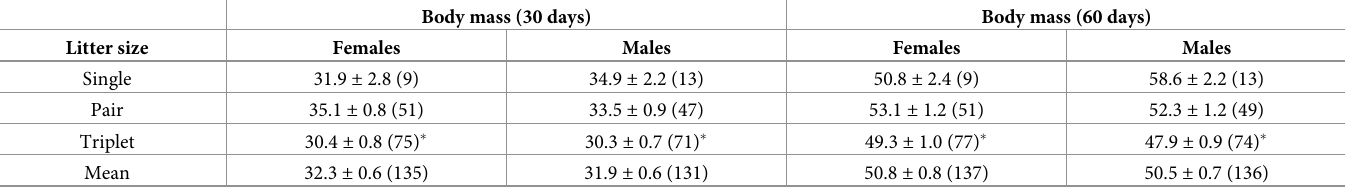
Table 1. Body mass (g, mean ± E) of female and male offspring at weaning time (30 days) and 60 days after birth depending on litter